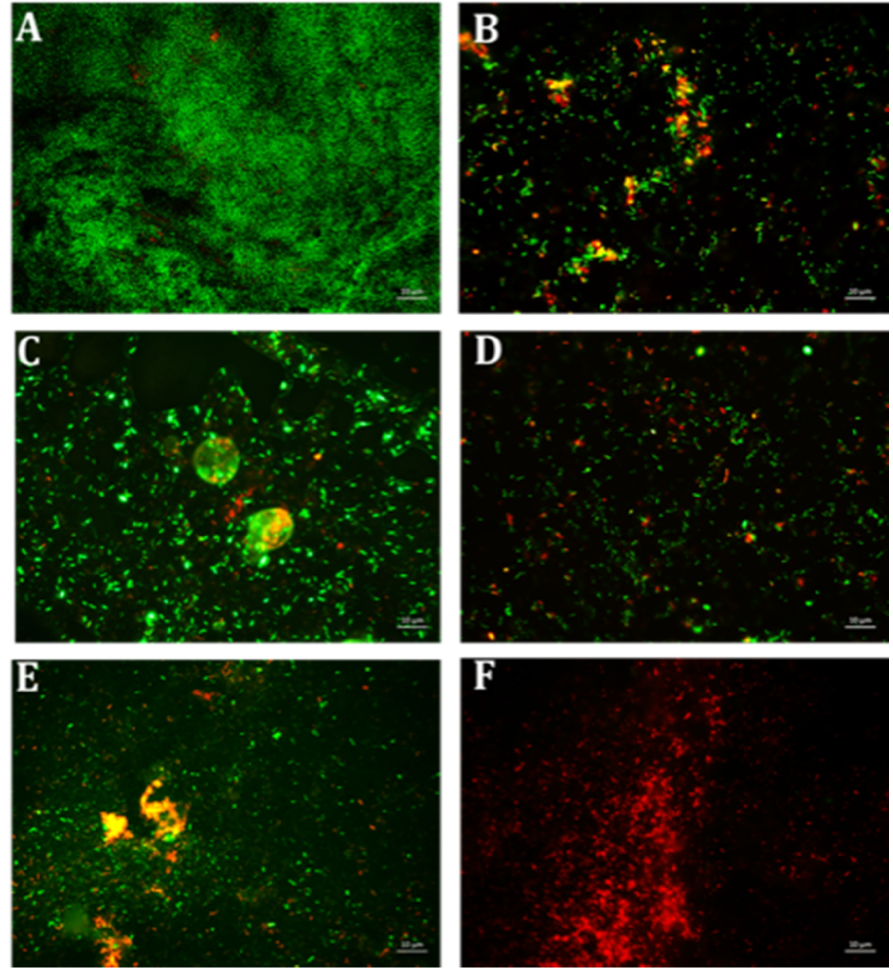
Figure 6. Fluorescence microscopic observation of cell viability on P. aeruginosa biofilm formation. E: erythromycin; ES: EGCG-S. Scale bar = 10 μ m. ( A ) Control, ( B ) E15, ( C ) ES25, ( D ) ES50, ( E) E15+ES50, and ( F ) E15+ES100. The results indicated that E15+ES100 severely affect the viability of the